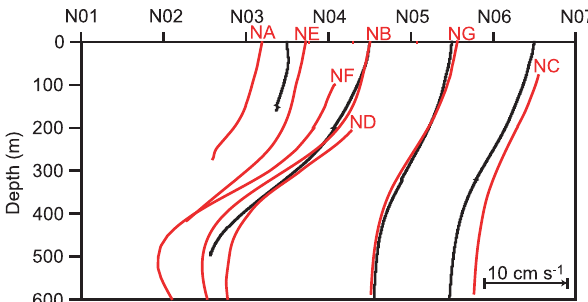
Figure 4. Average eastward geostrophic velocity profiles (black) between each pair of neighboring standard stations from N03 to N07 and eastward ADCP velocity profiles from all sites (red). The surface expressions of the geostrophic profiles are located in the middle of the associated station pairs. For the long-term sites, the profiles have been extrapolated to the surface where they are located at the ADCP